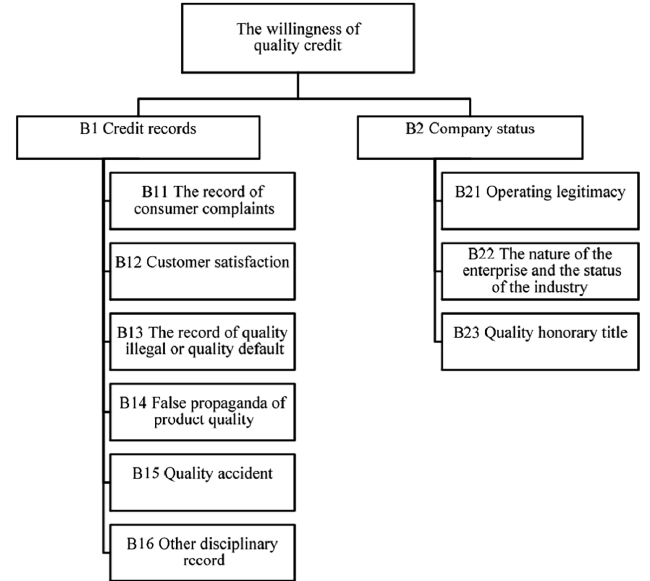
Figure 3. Hierarchy of quality credit willingness